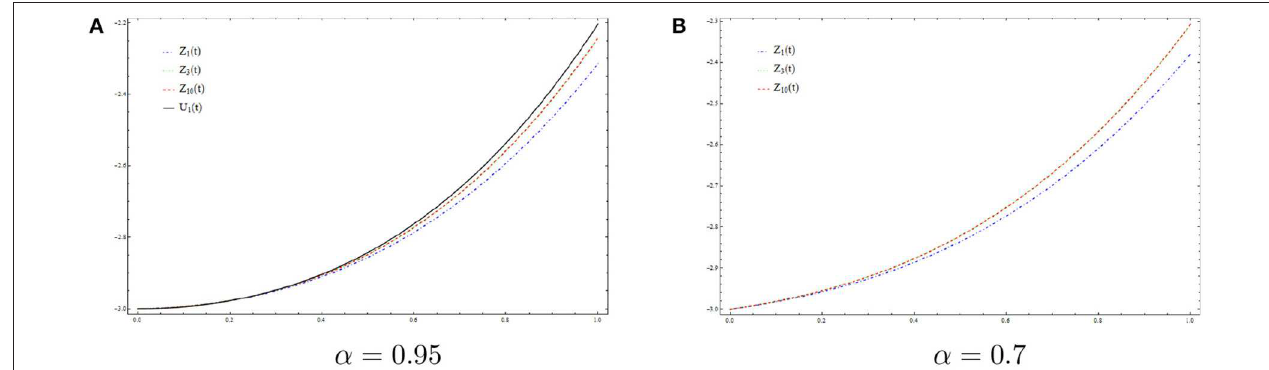
FIGURE 1 | Picard iterations for different values of α . (A) α